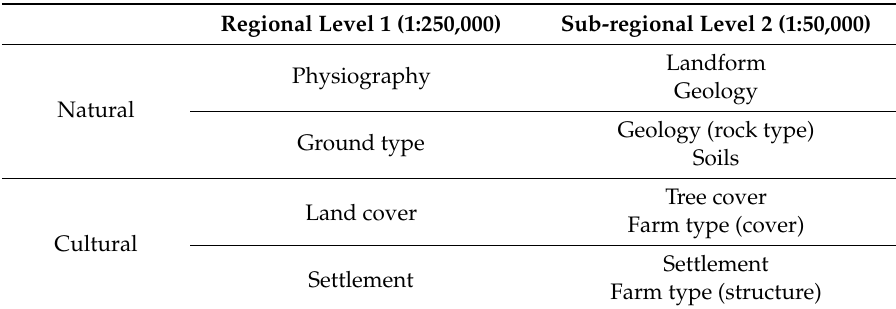
Table 1. Living Landscape Project, definitive attributes of landscape description units at Level 1 and Level 2